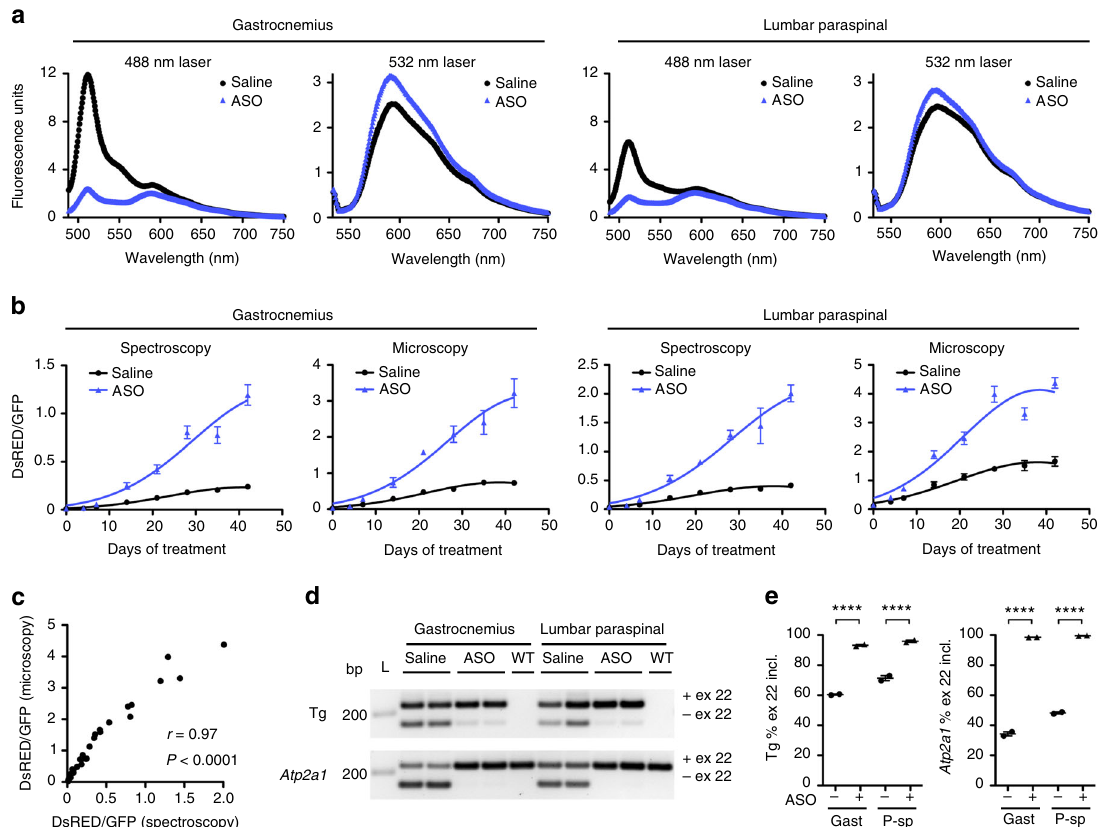
Fig. 5 Comparison of in vivo fl uorescence microscopy and spectroscopy. We treated TR;HSA LR bi-transgenic mice with saline or ASO 445236 ( N = 2 each) by subcutaneous injection (25 mg/kg twice weekly for 4 weeks) 8 and monitored DsRed and GFP fl uorescence using in vivo spectroscopy and microscopy for 6 weeks. a Representative corrected fl uorescence spectra, excited at 488 nm and 532 nm in gastrocnemius (left) and lumbar paraspinal (right) muscle 42 days after beginning treatment with saline (black circles) or ASO (blue triangles). b Serial in vivo fl uorescence spectroscopy and microscopy measurements through 42 days showing ratio of fi tted DsRed fl uorescence magnitude to fi tted GFP fl uorescence magnitude in gastrocnemius and lumbar paraspinal muscles of TR;HSA LR bi-transgenic mice treated with saline (black circles) or ASO (blue triangles). Error bars indicate mean ± s.e.m. Non-linear regression. c Correlation of DsRed/GFP values as measured by spectroscopy ( x -axis) and microscopy ( y -axis) at each time point. The correlation coef fi cient r and P value are shown. d Exon 22 splicing analysis by RT-PCR of transgene (Tg) and endogenous mouse Atp2a1 in gastrocnemius and lumbar paraspinal muscles of saline- and ASO-treated mice at Day 42. L DNA ladder, bp base pairs. e Quantitation of the splicing results in d . Error bars indicate mean ± s.e.m. **** P < 0.0001, saline vs. ASO; two-way